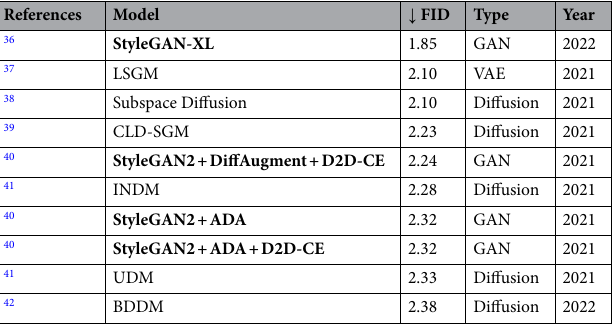
Table 3. CIFAR-10 FID score benchmark for unconditional image generation. GAN: Generative Adversarial Network; VAE: Variational AutoEncoder. Diffusion: Diffusion model. StyleGAN and derivatives in